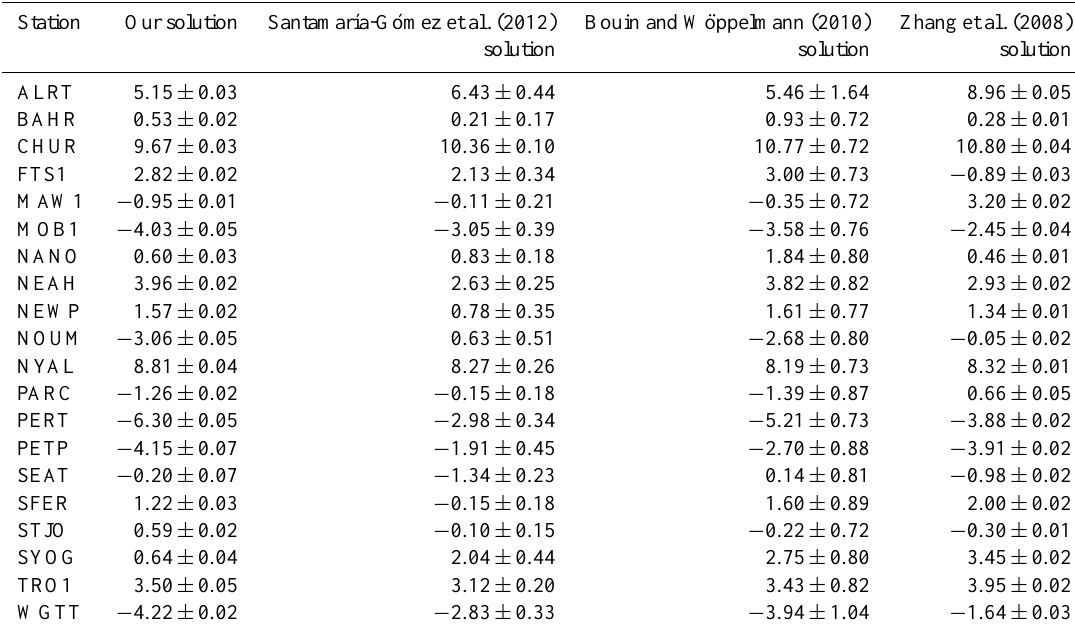
Table 3. Comparison of the vertical velocities (mmyr − 1 ) of GPS stations common in our and three recent solutions.